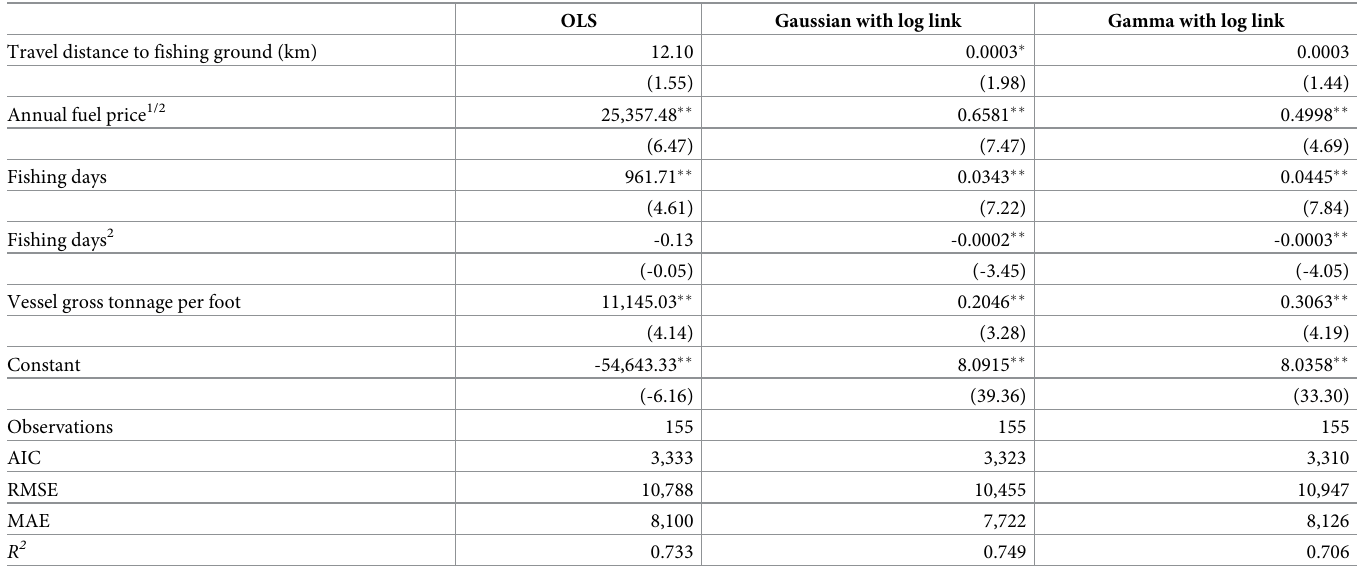
Table 7. Model results for American Samoa longline fishery tip